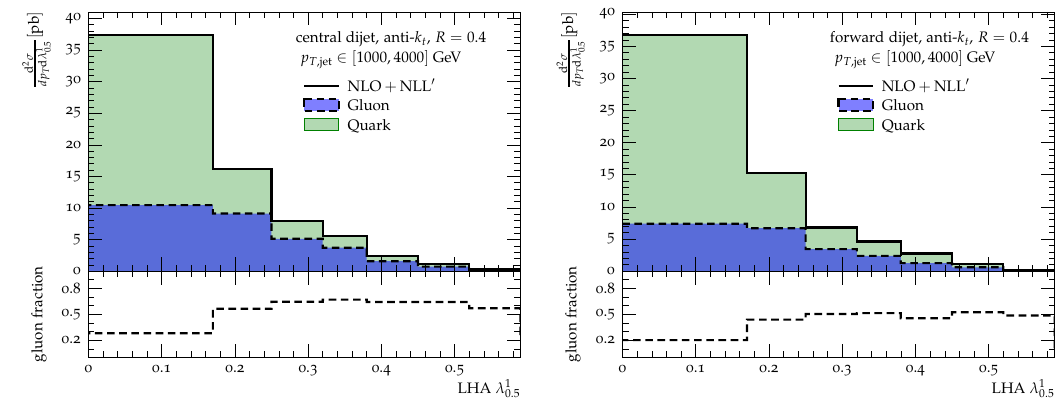
Figure 7. NLO + NLL 0 accurate predictions for the quark- and gluon-jet contribution to the Les Houches Angularity λ 1 for the central (left) and forward (right) dijet event selection, with jets 0 . 5 in the range p T, jet ∈ [1000 , 4000] GeV. The lower panels show the gluon fractions in the respective angularity